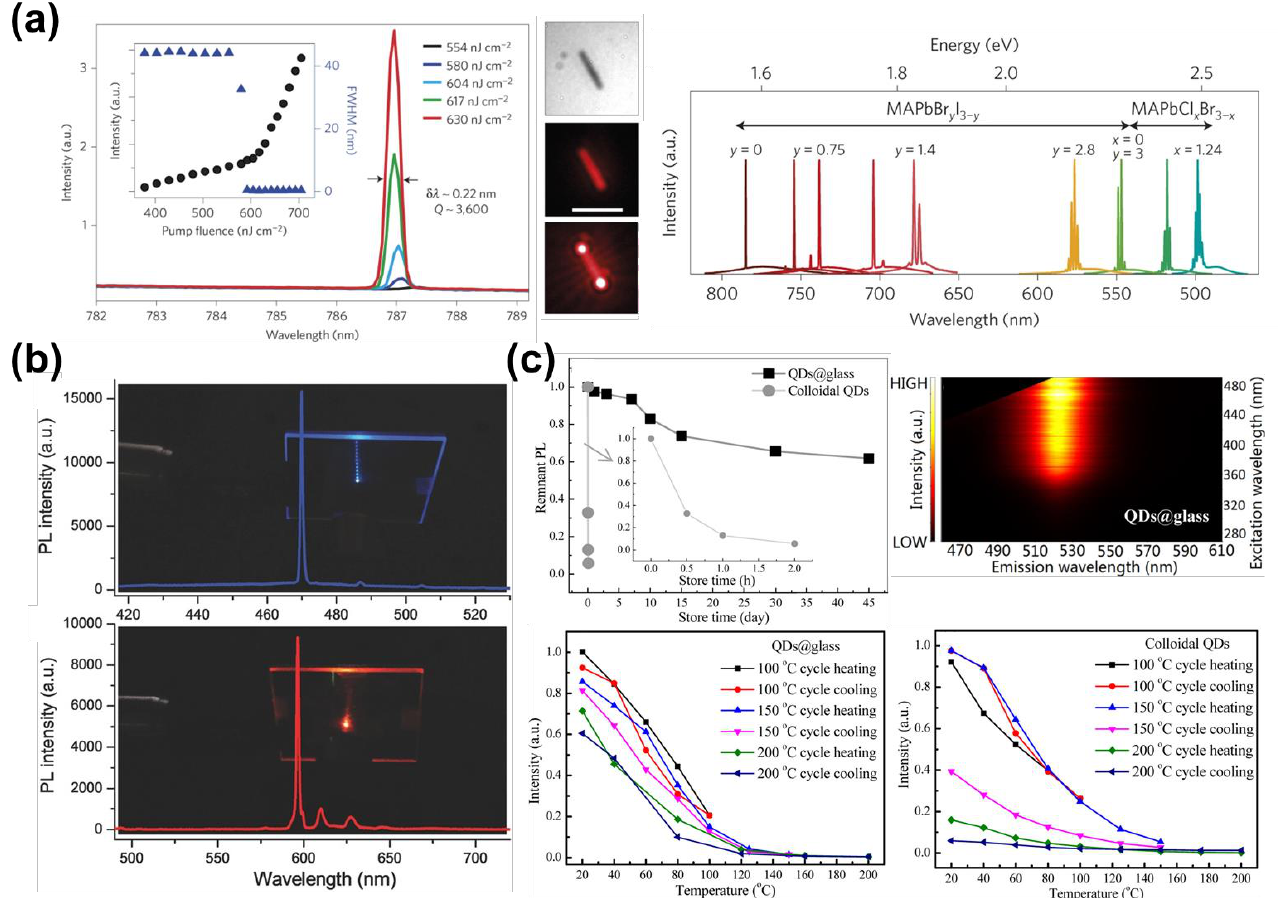
Figure 17. ( a ) Integrated emission intensity and FWHM as a function of P of MAPbI 3 NWs, the optical image of single NW, and the widely tunable lasing emission wavelength form single-crystal MAPbX 3 NW lasers. [9]. Copyright 2015 Nature Publishing Group. ( b ) Blue and red lasing spectra of vertical cavity surface emitting lasers from CsPb(Br/Cl) 3 and CsPb(I/Br) 3 perovskite NCs under pump intensity of 38.2 and 30.5 µ J/cm 2 [91]. Copyright 2017 John Wiley & Sons, Inc. ( c ) Water resistance test by directly immersing QDs@glass/Colloidal QDs in aqueous solution, two-dimensional excitation- emission mapping of QDs@glass, and temperature-dependent PL intensities for QDs@glass and colloidal QDs via three heating/cooling cycles [92]. Copyright 2018 American Chemical